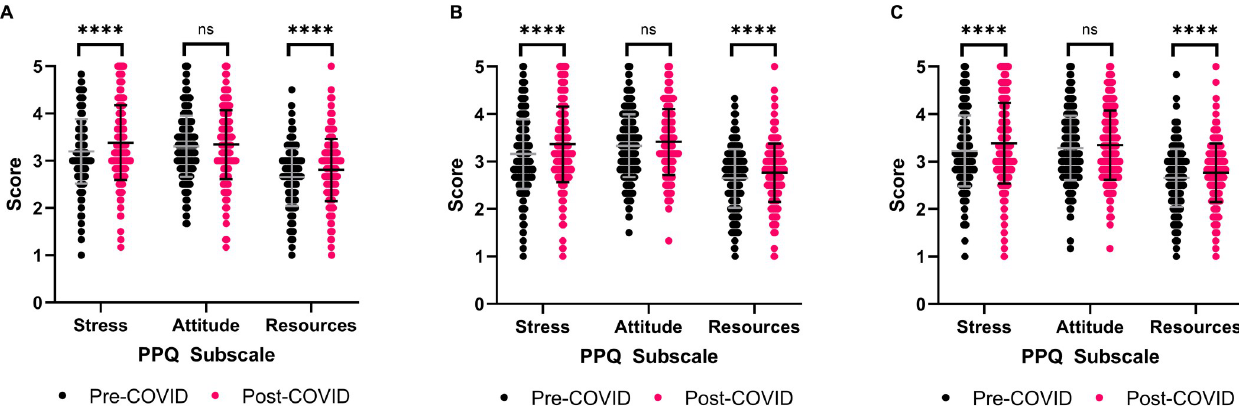
Fig 3. Differences in publication pressure questionnaire subscale scores pre- and post-COVID stratified by research funding agency. Paired Student’s t- test with Bonferroni correction. ���� P � 0.0001. (A) Canadian Institutes of Health Research respondent scores. N = 321. (B) Natural Sciences and Engineering Research Council respondent scores. N = 306. (C) Social Sciences and Humanities Research Council respondent scores. N = 393.